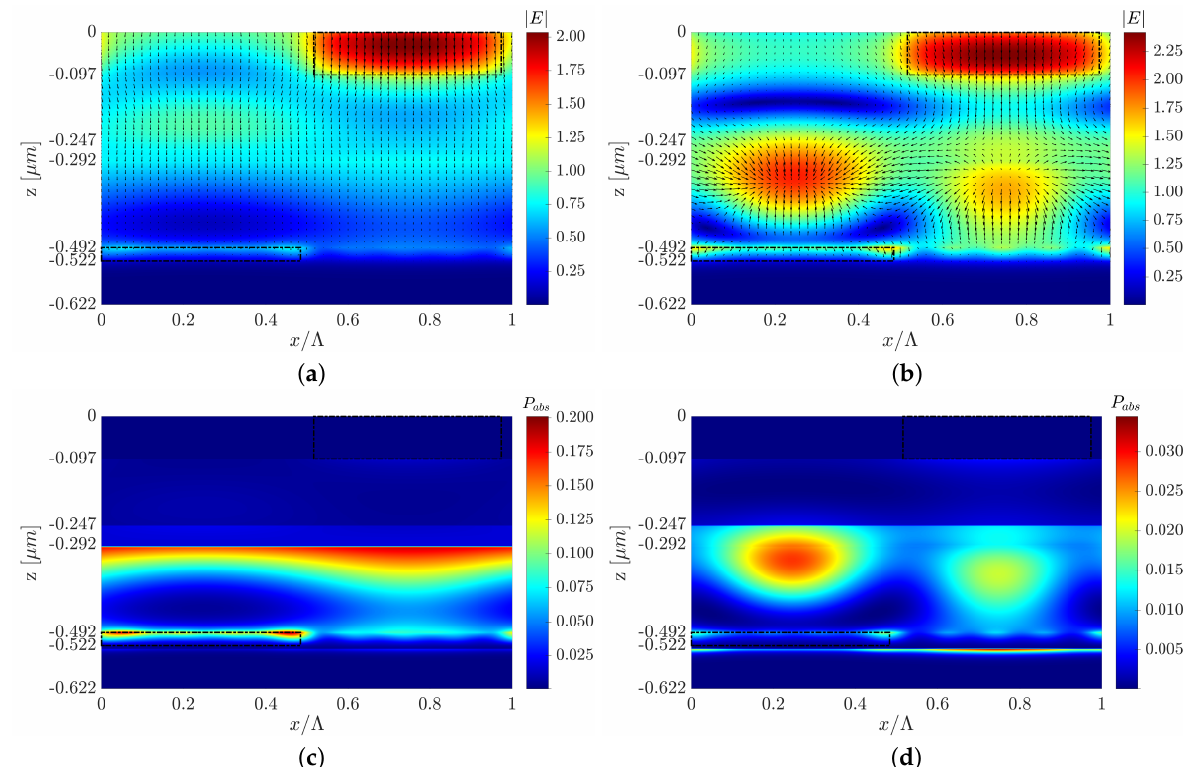
Figure 7. Electric field intensity and quiver plot of the Poynting vector of structure C at ( a ) λ = 600 nm and ( b ) λ = 650 nm, and the normalized absorbed power profile color map of structure C at ( c ) λ = 600 nm and ( d ) λ = 650 nm, where the y cross-section is at the center of the P3HT:PCBM grating